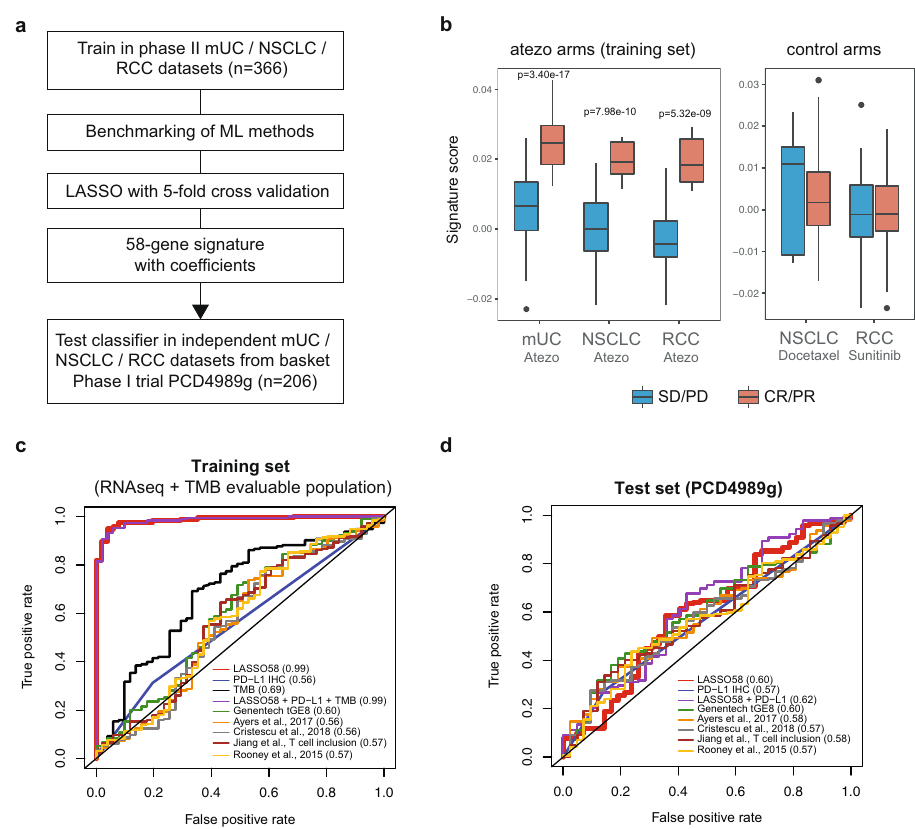
Fig. 2 Machine learning to identify a transcriptional signature of response to PD-L1 blockade. a Flowchart depicting the approach to identify the signature. b Left panel, bar chart representing the signature score by indication and response group within the RNA-seq and TMB-evaluable population in the atezolizumab arms of the training set. n = 144 mUC, n = 50 NSCLC, and n = 52 RCC biologically independent samples were examined. Right panel, bar chart representing the signature score in the control arms of POPLAR (NSCLC, docetaxel arm) and IMmotion150 (RCC, sunitinib arm) clinical trials. n = 75 NSCLC and n = 85 RCC biologically independent samples were examined. The center of the boxplots represents the median. The lower and upper hinges correspond to the fi rst and third quartiles. The upper whisker extends from the hinge to the largest value no further than 1.5 × IQR (interquartile range) from the hinge. The lower whisker extends from the hinge to the smallest value at most 1.5 × IQR of the hinge. P values were calculated using the non- corrected two-sided Wilcoxon rank-sum test. c ROC curves for the 58-gene signature, PD-L1, TMB, and external signatures in the RNA-seq/TMB- evaluable population. AUC values are displayed in parenthesis. d Same as c for the independent phase I PCD4989g test combined with fi vefold cross-validation (Fig. 2a) yielded a weighted 58-gene signature (Supplementary Data 2) that could segregate responders from nonresponders in the training set (Fig. 2b, left panel). In the chemotherapy (docetaxel) arm from POPLAR (NSCLC) and the tyrosine kinase inhibitor (sunitinib) arm from IMmotion150 (RCC), no signi fi cant difference in sig- nature levels was observed between responders and non- responders, suggesting a predictive value for this signature for response to atezolizumab (Fig. 2b, right panel).